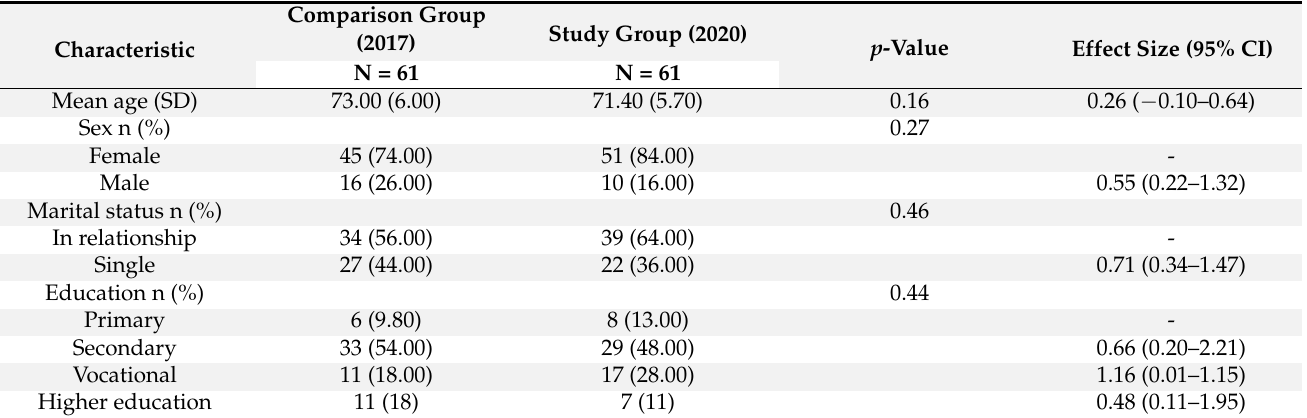
Table 2. Baseline characteristics for both